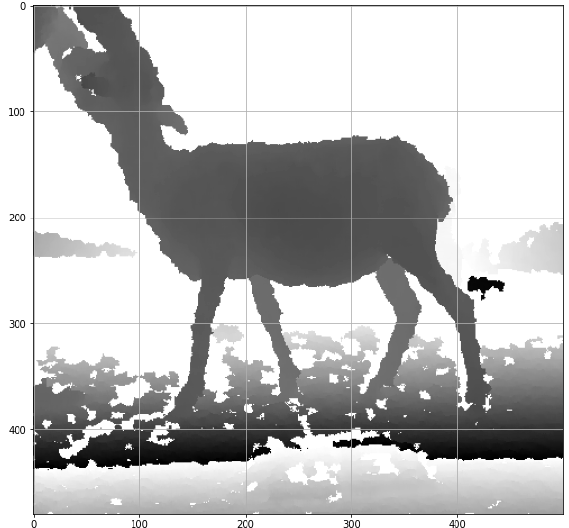
Figure 4. Depth image from the Kinect ®